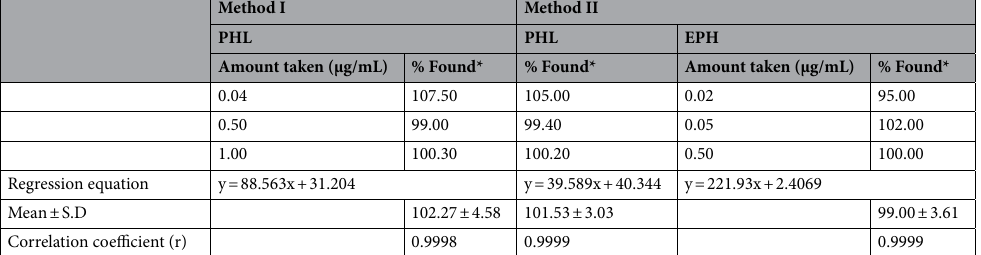
Table 6. Determination of pholcodine and ephedrine in spiked human plasma samples using the proposed methods. *Each result is average of 3 separate determinations.